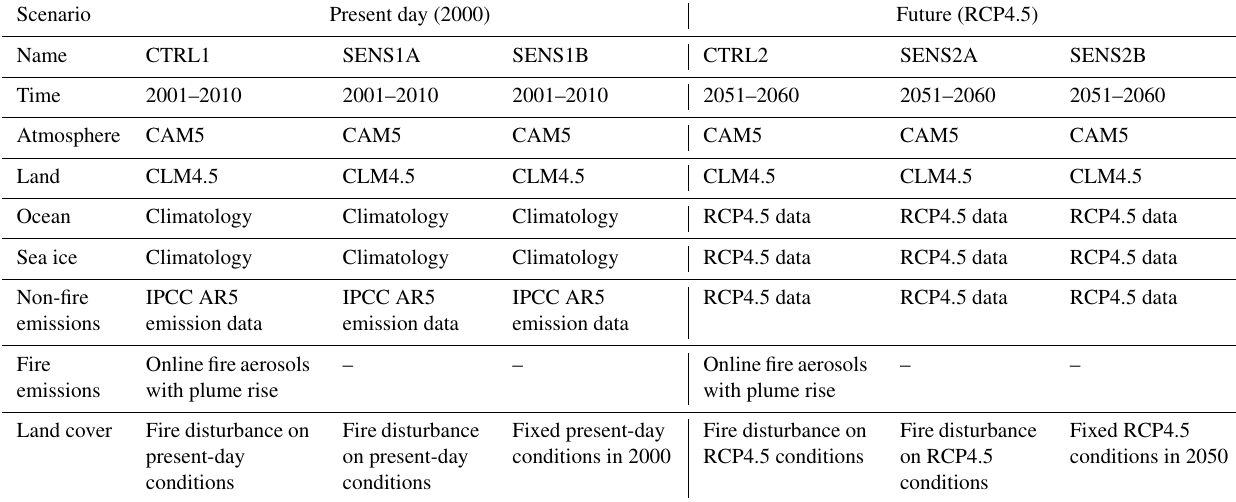
Table 1. Fire sensitivity simulation experiments for the present-day and RCP4.5 future scenarios.